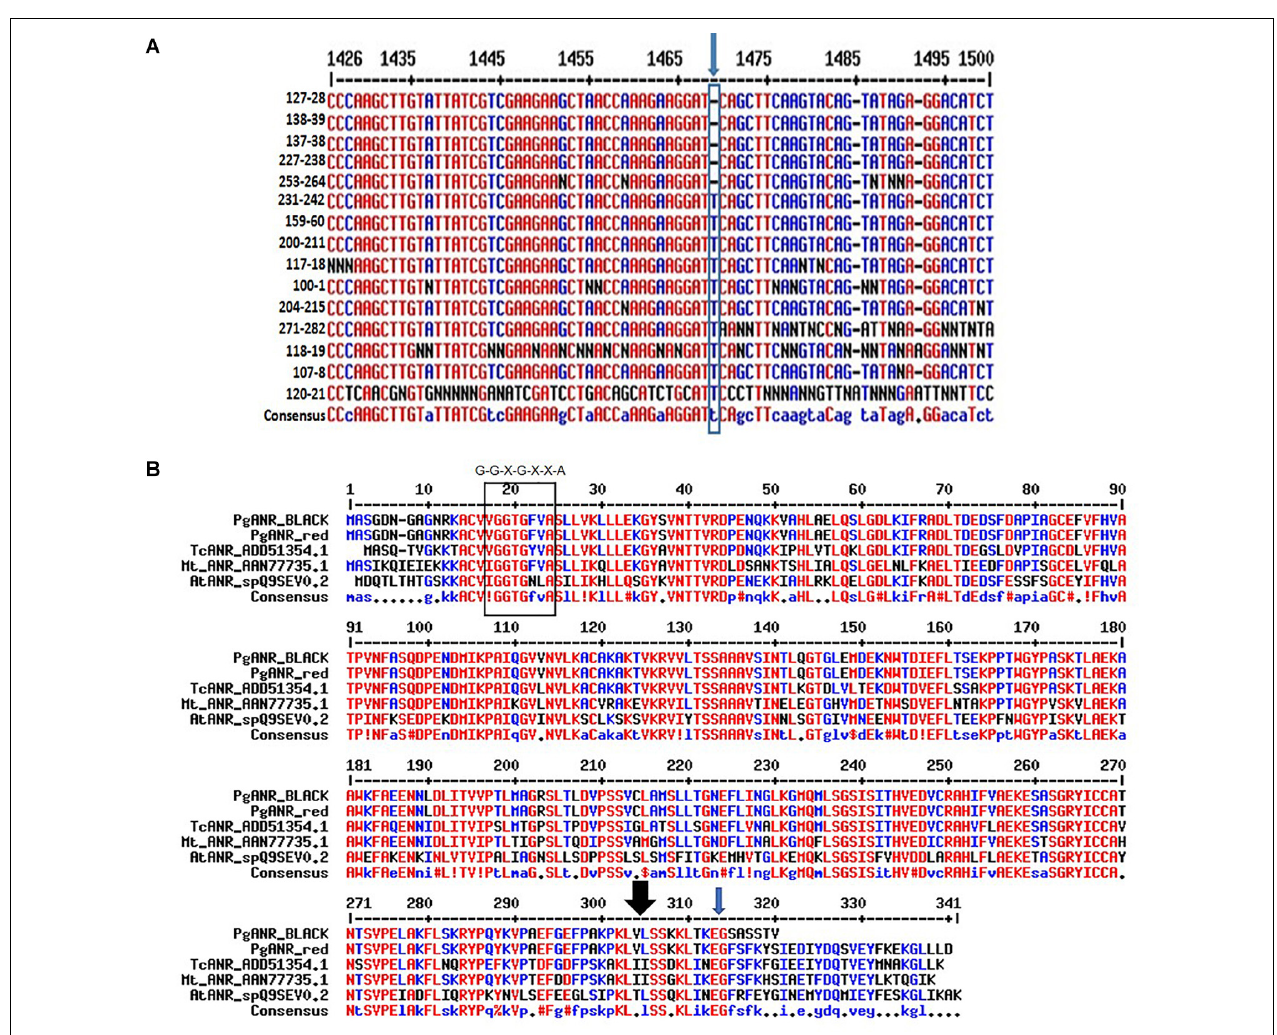
FIGURE 8 | Characterization of the ANR mutation. (A) The site and nature of the ANR mutation in the DNA sequence corresponding to the ANR gene. Multiple alignment of partial nucleotide sequence showing the mutation (blue arrow). Details of varieties shown are in Supplementary Table 1 . (B) Multiple alignment of the deduced pomegranate proteins corresponding to ANR. The rectangle at the N terminus of the protein shows the conserved Rossmann dinucleotide-binding domain amino-termini (G-G-X-G-X-X-A). The black arrow at the C terminus of the protein shows the area of a putative substrate binding site. The ANR proteins shown in the alignment are- Arabidopsis thaliana AtANR_spQ9SEV, Medicago truncatula MtANR_AAN77735.1, Gossypium hirsutum GhANR_ABM64802.1 and Glycine max G.max_ANR2_NP_001243072.1.